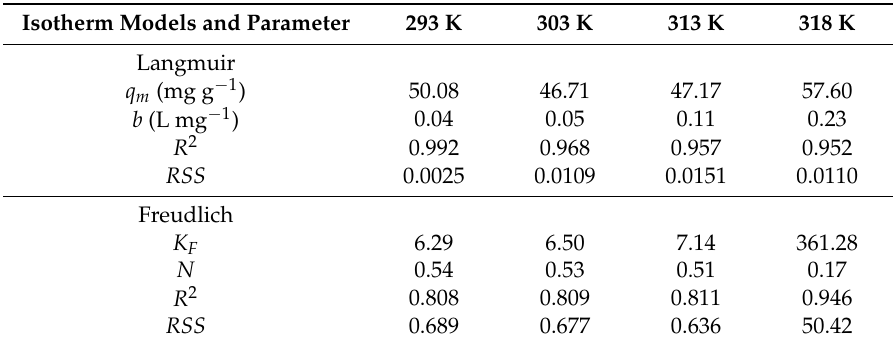
Table 5. Isotherm parameters for the uptake of As(III) by adsorption onto MNP-Maph at different temperatures.